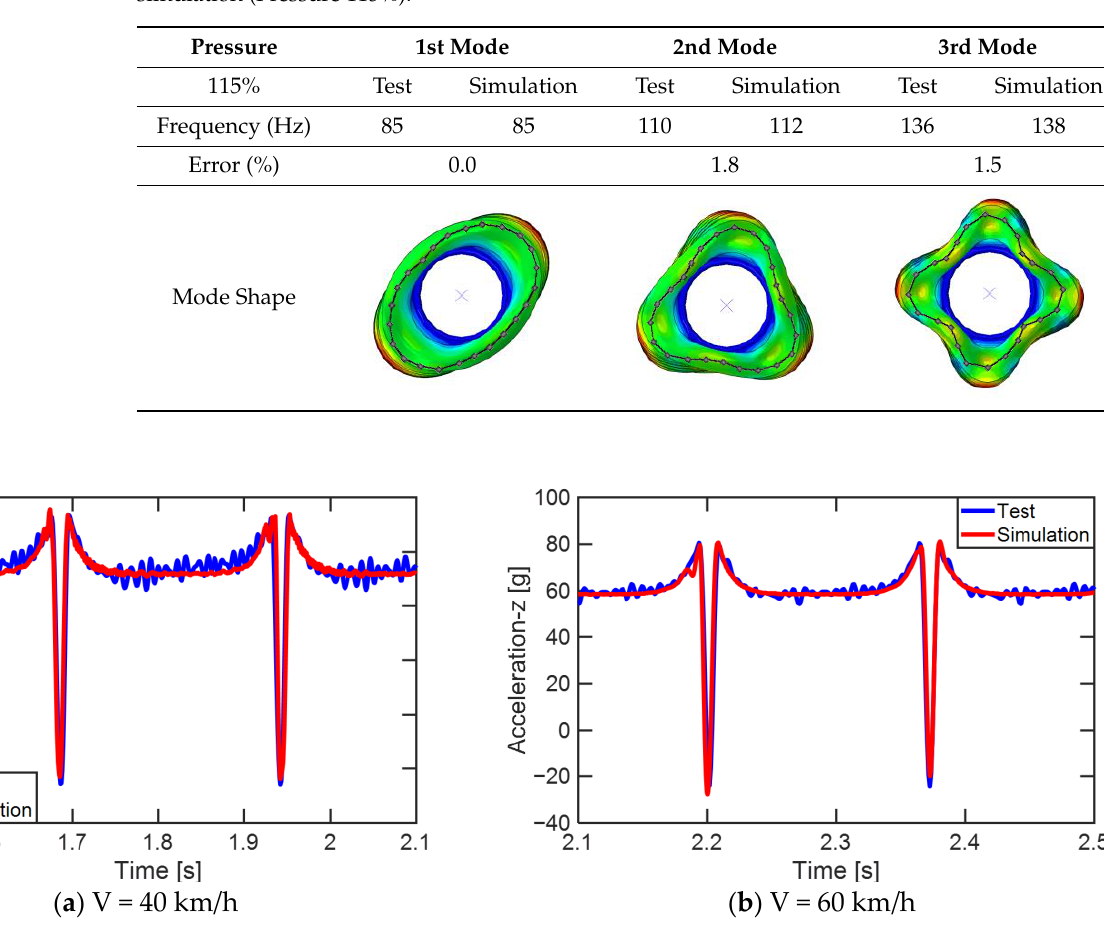
Figure 12. Comparison of the radial component of the internal tire accelerations under the drum rolling conditions.